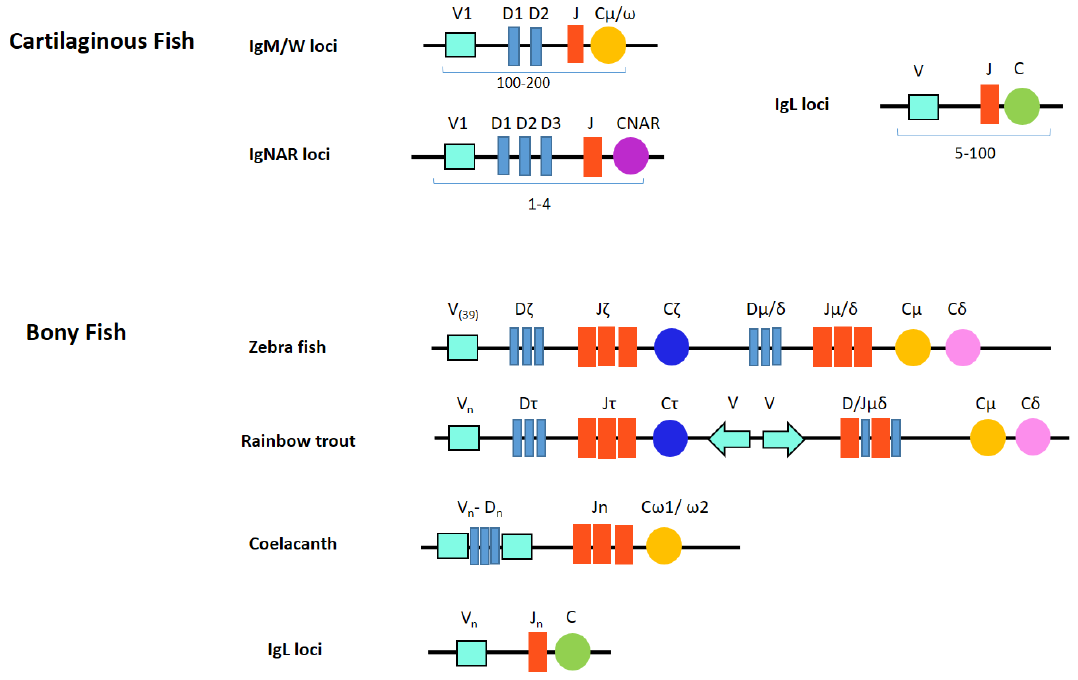
Figure 1. Both multiple cluster and translocon organizations are used in fish Ig